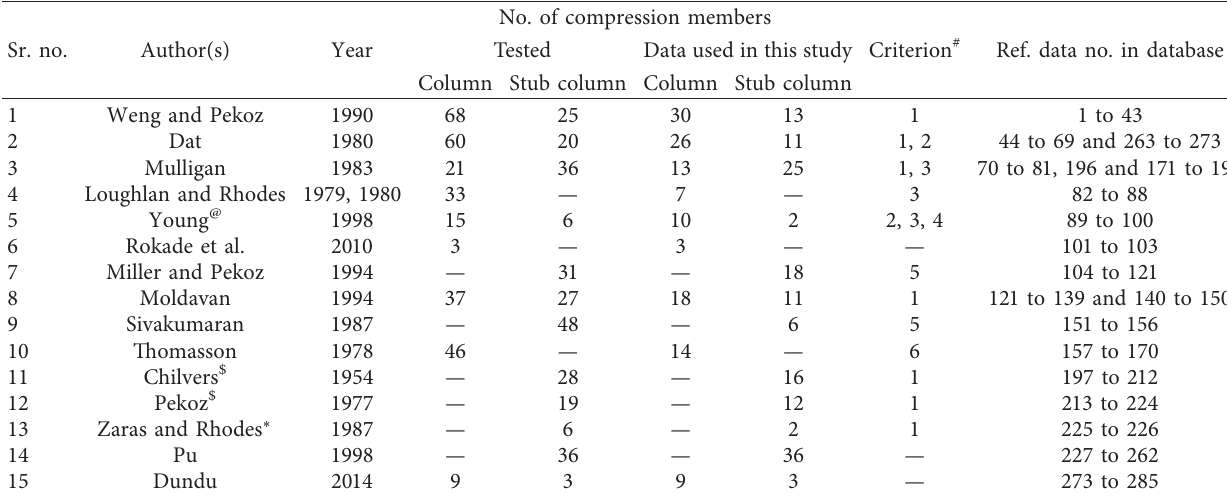
Table 3: Test database for cold-formed lipped channel compression